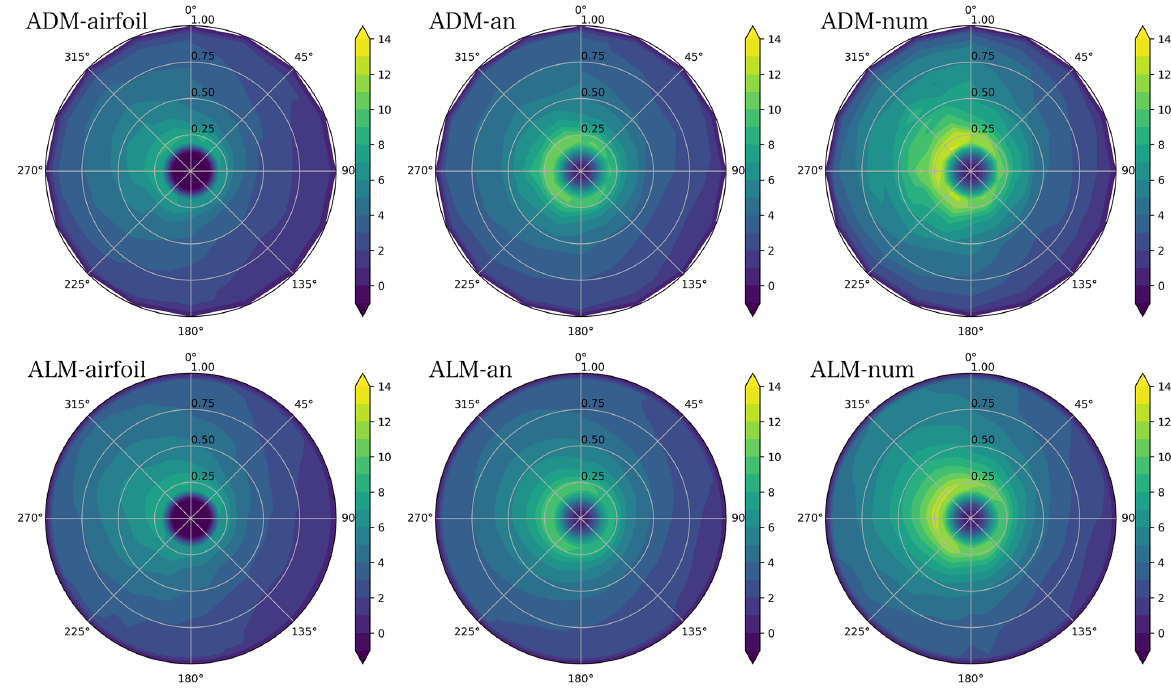
Figure 13. Model comparison for the time-averaged tangential force distribution (Nm − 2 ) on the impacted rotor (WT2) for ABL inflow. The wake from WT1 impacts the right side of the rotor